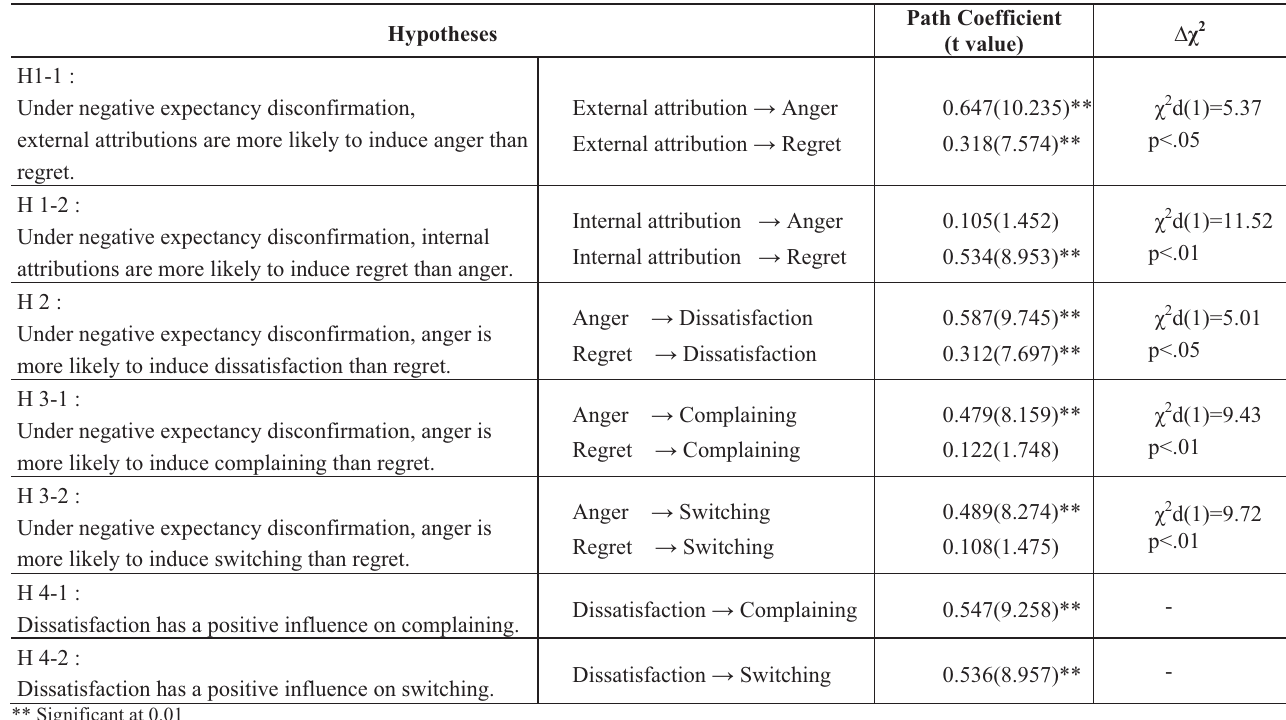
Table 3: Path analysis